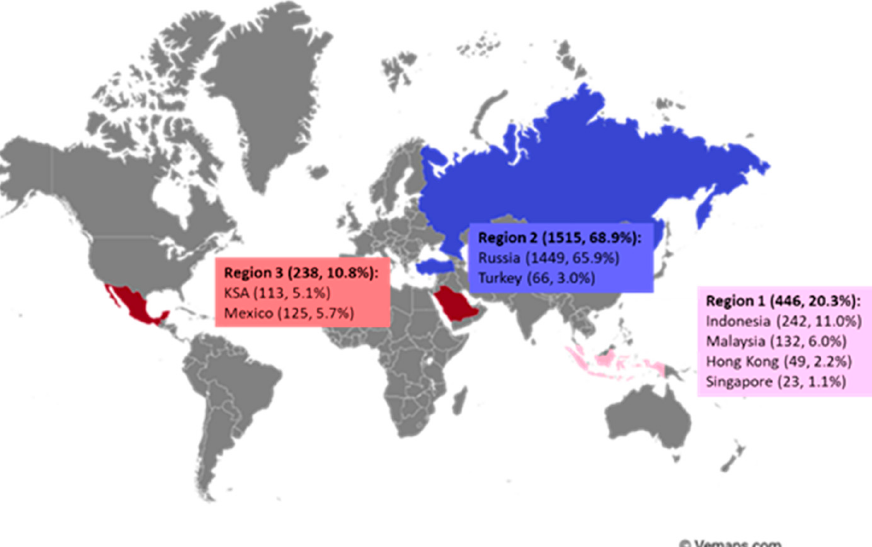
Figure 1. The geographical location of the survey respondents (number of respondents and % of total respondents).